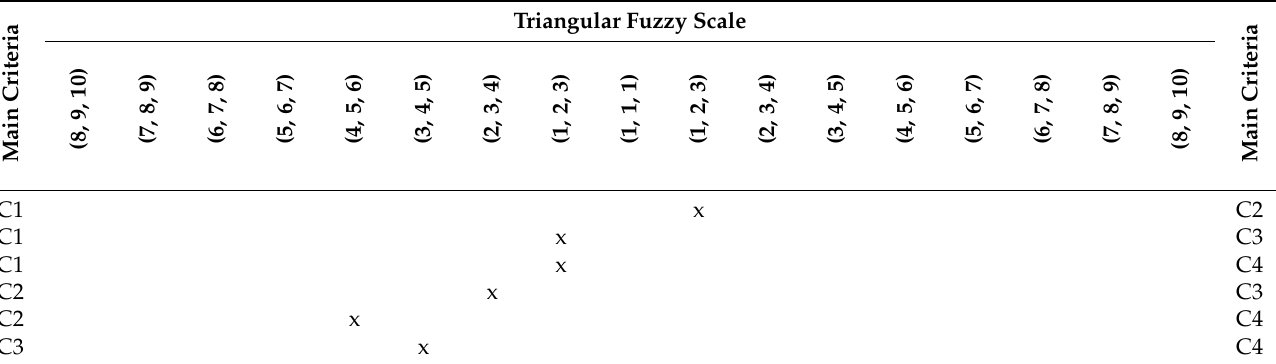
Table 4. The initial comparison matrix of FAHP model.